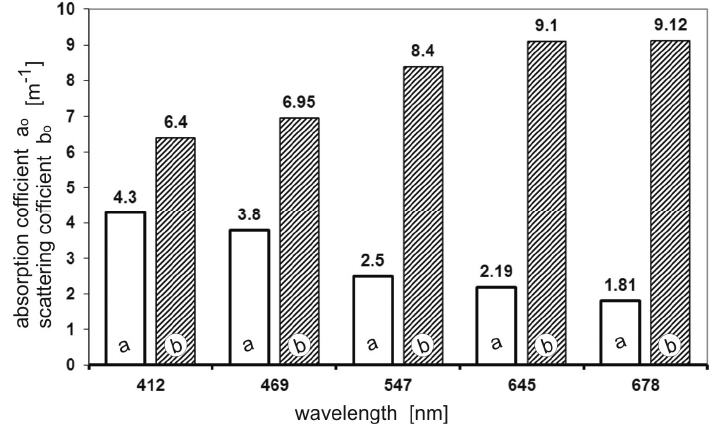
Figure 4. Two components of IOPs of the oil droplet suspension for 10 ppm applied in the model: absorption coefficient a o and scattering coefficient b o . The third component of IOPs—the Volume Scattering Function—is used according to Otremba et al. [8].